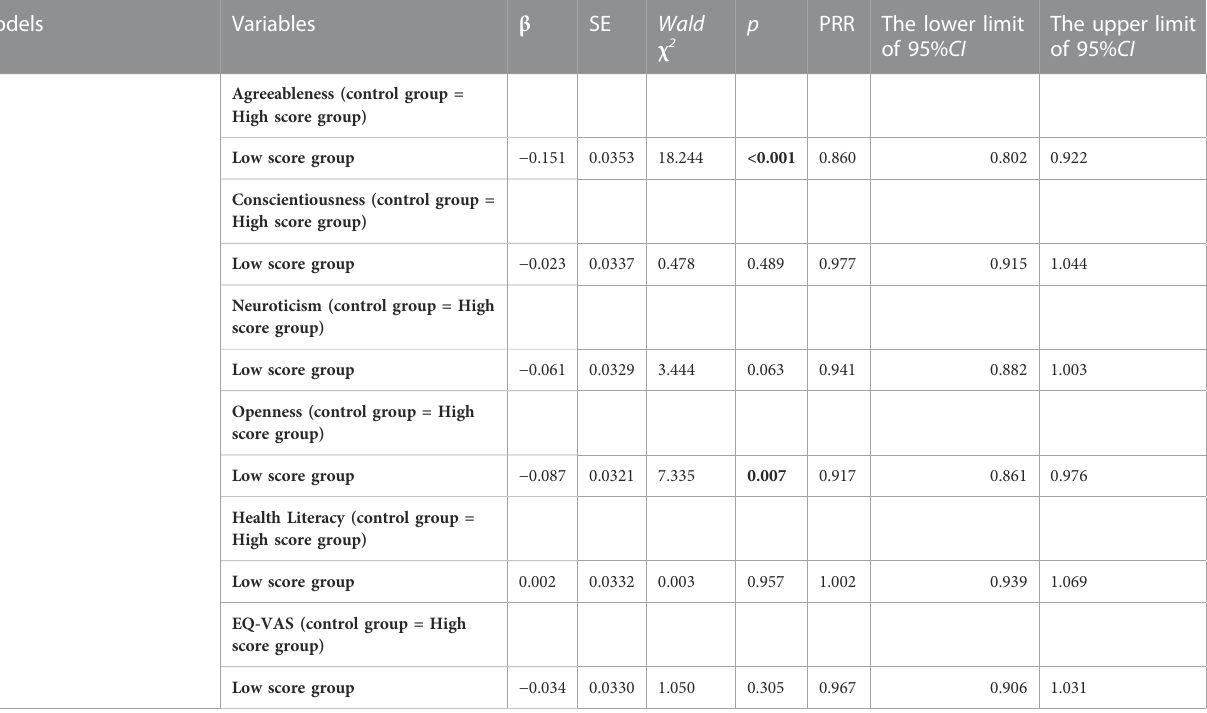
TABLE 5 ( Continued ) Results of analysis of subgroups by region (dependent variable: likelihood of residents focusing on safety).